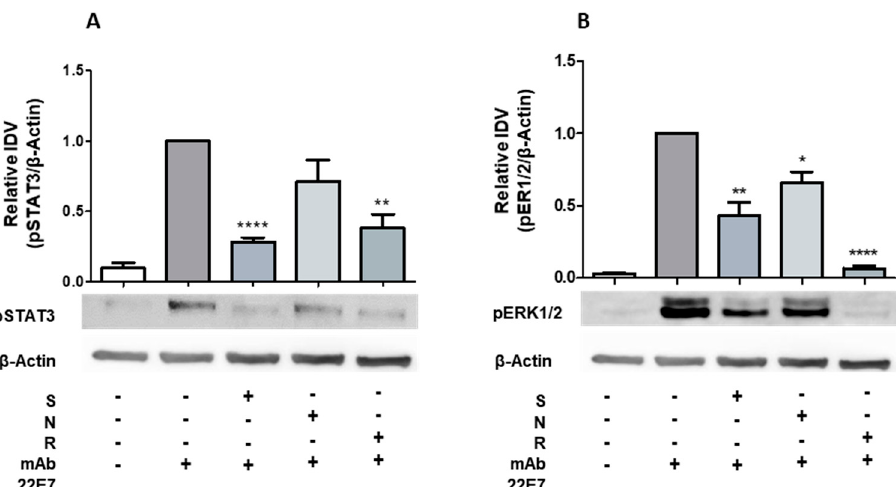
Figure 3. Phosphorylation of signal transducer and activator of transcription 3 (STAT3) and extracellular signal-regulated kinase 1/2 (ERK1/2) in hiMC following treatment with stattic, nobiletin, and resveratrol. Western blot analyses of ( A ) phosphorylated STAT3 ( n = 5) and ( B ) phosphorylated ERK1/2 ( n = 4) in hiMC. HiMCs were treated with 60 μ M of stattic (S), 45 μ M of nobiletin (N), 50 μ M of resveratrol (R), or corresponding concentrations of the vehicle DMSO (control) before stimulation by Fc ε RI crosslinking using 100 ng/mL of mAb 22E7 for 5 min. Representative pictures and densitometric analyses in relation to stimulated control are shown. Values are mean ± SEM. * p < 0.05, ** < 0.01, **** p < 0.0001.